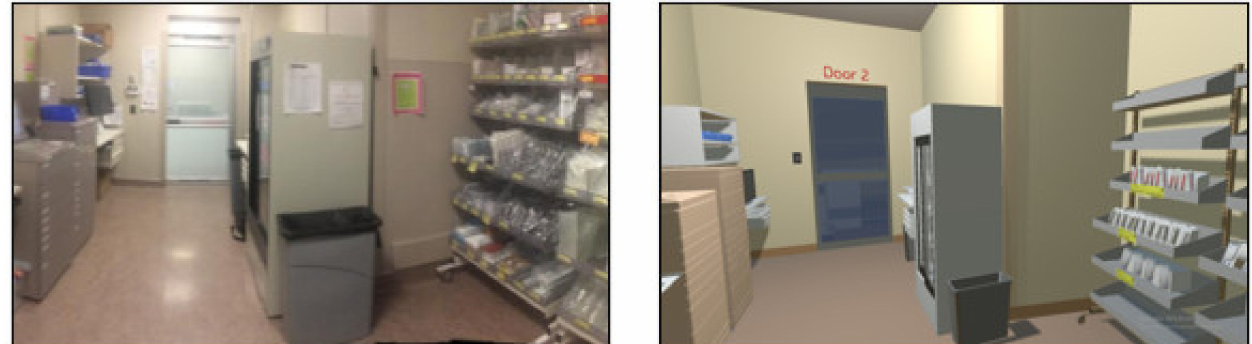
Figure 1. Existing medication room ( left ) and VR medication room mock-up ( right